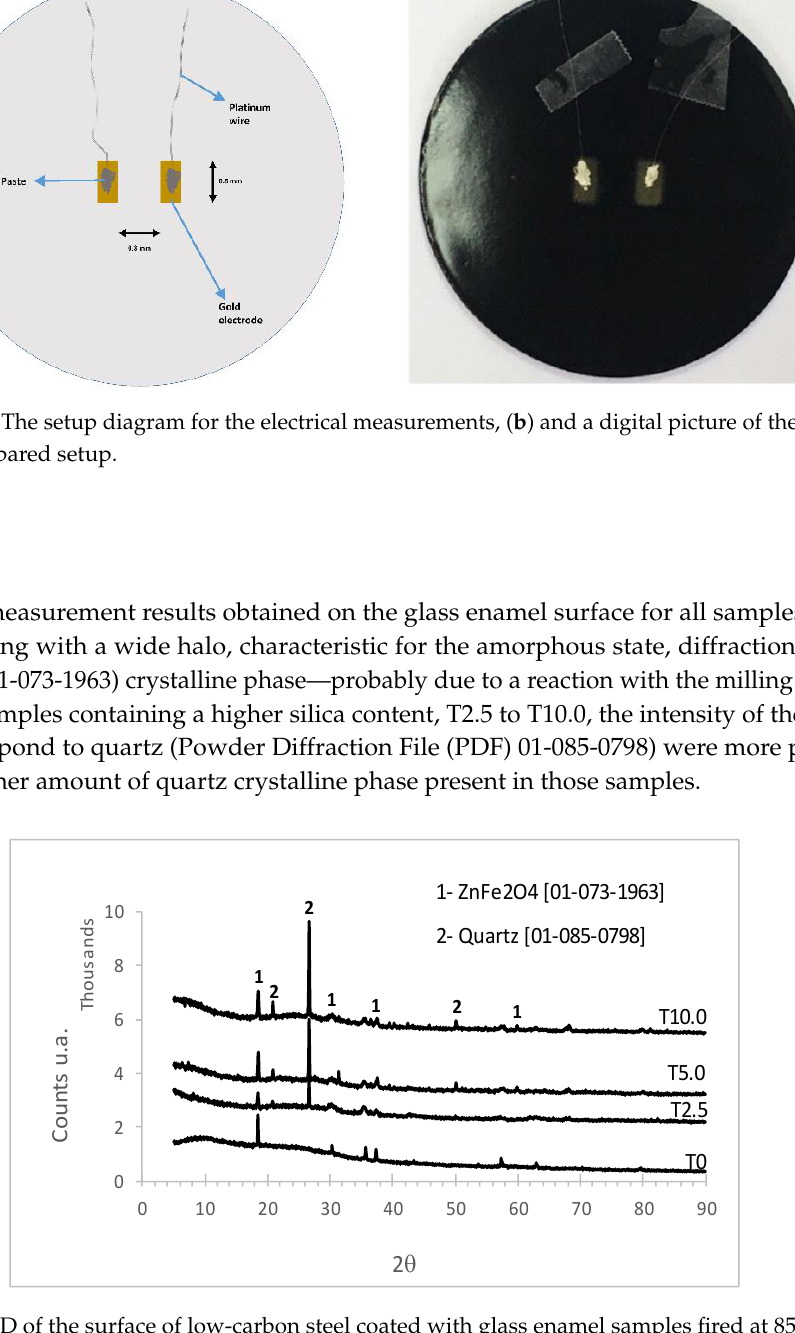
Figure 3. XRD of the surface of low-carbon steel coated with glass enamel samples fired at 850 °C for 4 min.